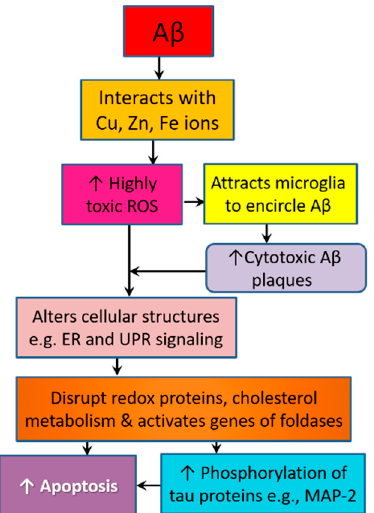
Figure 2. Beta-amyloid protein fragments induce multiple molecular and cellular changes that promote neurodegeneration. Abbreviations: ↑ denotes increase, A β : beta-amyloid protein fragments, ROS: reactive oxygen species, ER: endoplasmic reticulum, UPR: unfolded protein response, MAP-2: microtubule-associated protein 2. A β pathology contributes to various molecular and cellular changes that induce neuronal death.